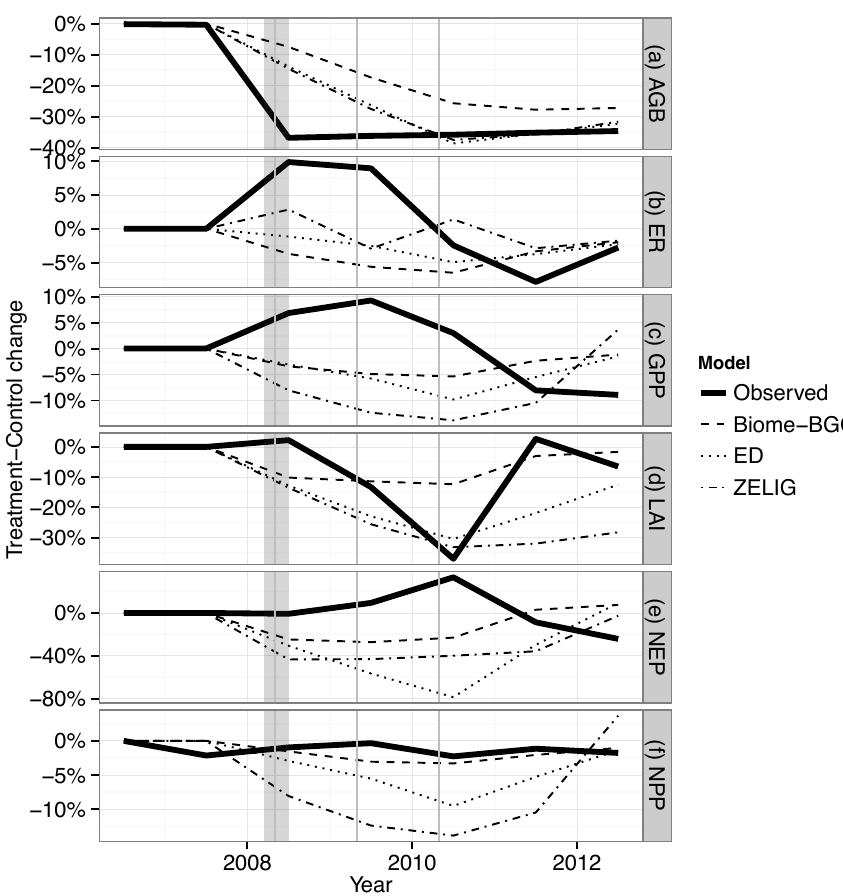
Figure 2. Model performance in replicating the FASET experiment. Panels include (a) aboveground biomass (AGB, in MgCha − 1 ) , (b) ecosystem respiration (ER, MgCha − 1 ) , (c) GPP (MgCha − 1 ) , (d) leaf area index (LAI, unitless), (e) net ecosystem production (NEP, MgCha − 1 ) , and (f) net primary production (NPP, MgCha − 1 ) , all expressed on a common normalized scale (relative change between treat- ment and control). Vertical shaded area shows approximate time of the girdling treatment described in the text. Vertical lines show May 1 forest harvests imposed in the Biome-BGC, ED, and ZELIG